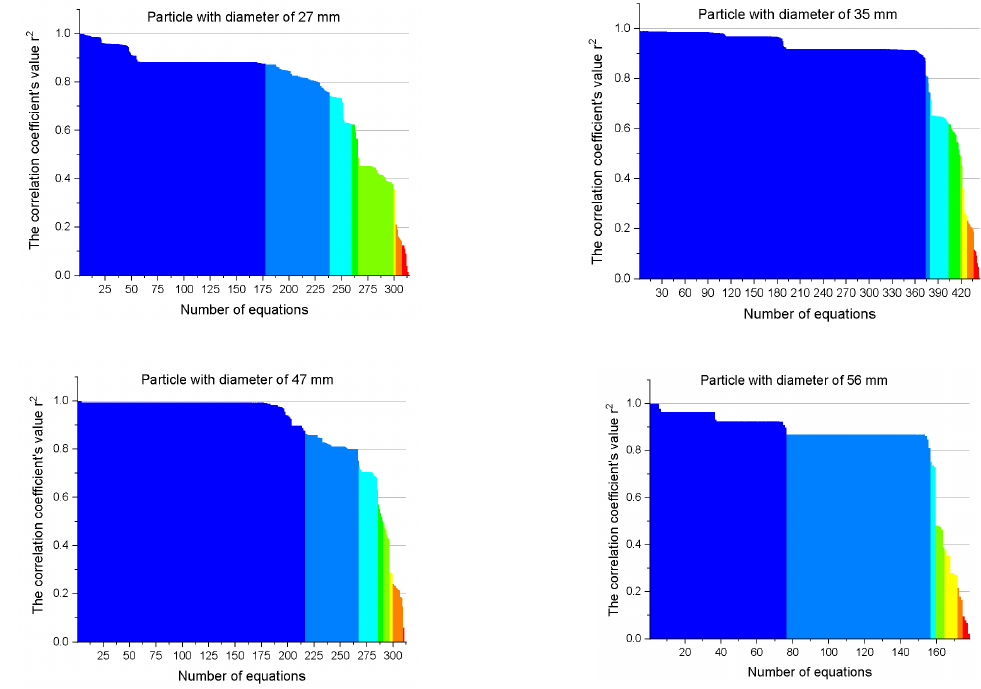
Figure 6. The number of equations generated by the Table Curve 3D program is represented as a function of the coefficient r 2 for the variation of the average angular velocity [43]. The Table Curve 3D application generated a large number of equations: - A total of 338 equations were obtained for the average value of the instantaneous velocity for the particle with a diameter of 27 mm (maximum number of the